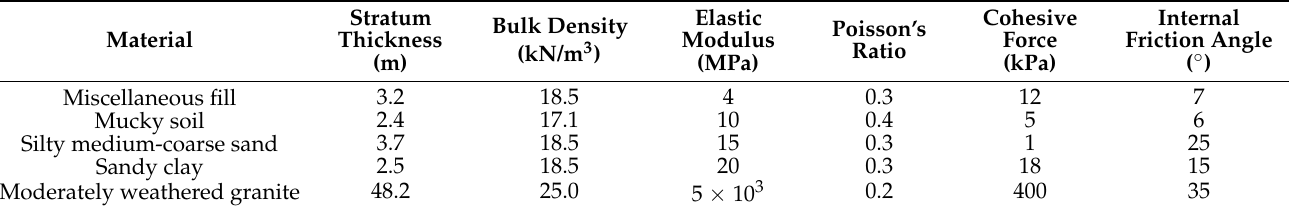
Table 3. Geotechnical parameters of the surrounding rock.